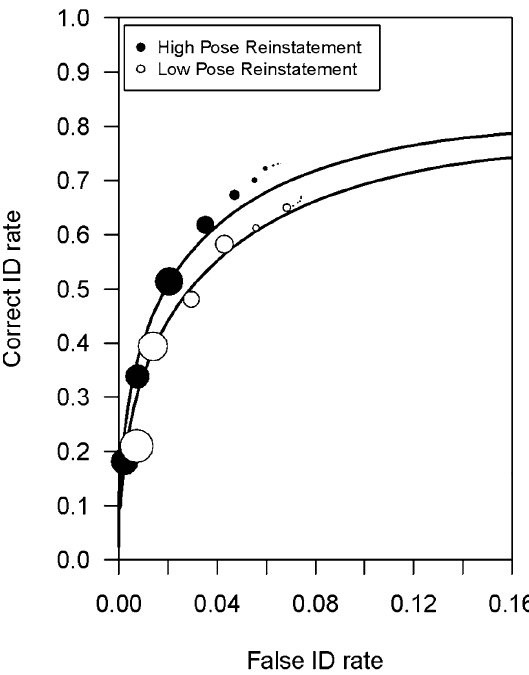
Figure 4. Experiment 2 ROC data for the high pose-reinstatement and low pose-reinstatement participants. In ( A ), the circles are the empirical data and the curved lines of best fit were generated using the Independent Observations model. The bottom x-axis shows the estimated false ID rate of innocent suspects. The dashed line indicates chance-level performance. The size of the symbols represents the number of suspect IDs at a given level of confidence relative to the total number of suspect IDs collapsed across all levels of confidence (Seale- Carlisle et al., 2019) 34